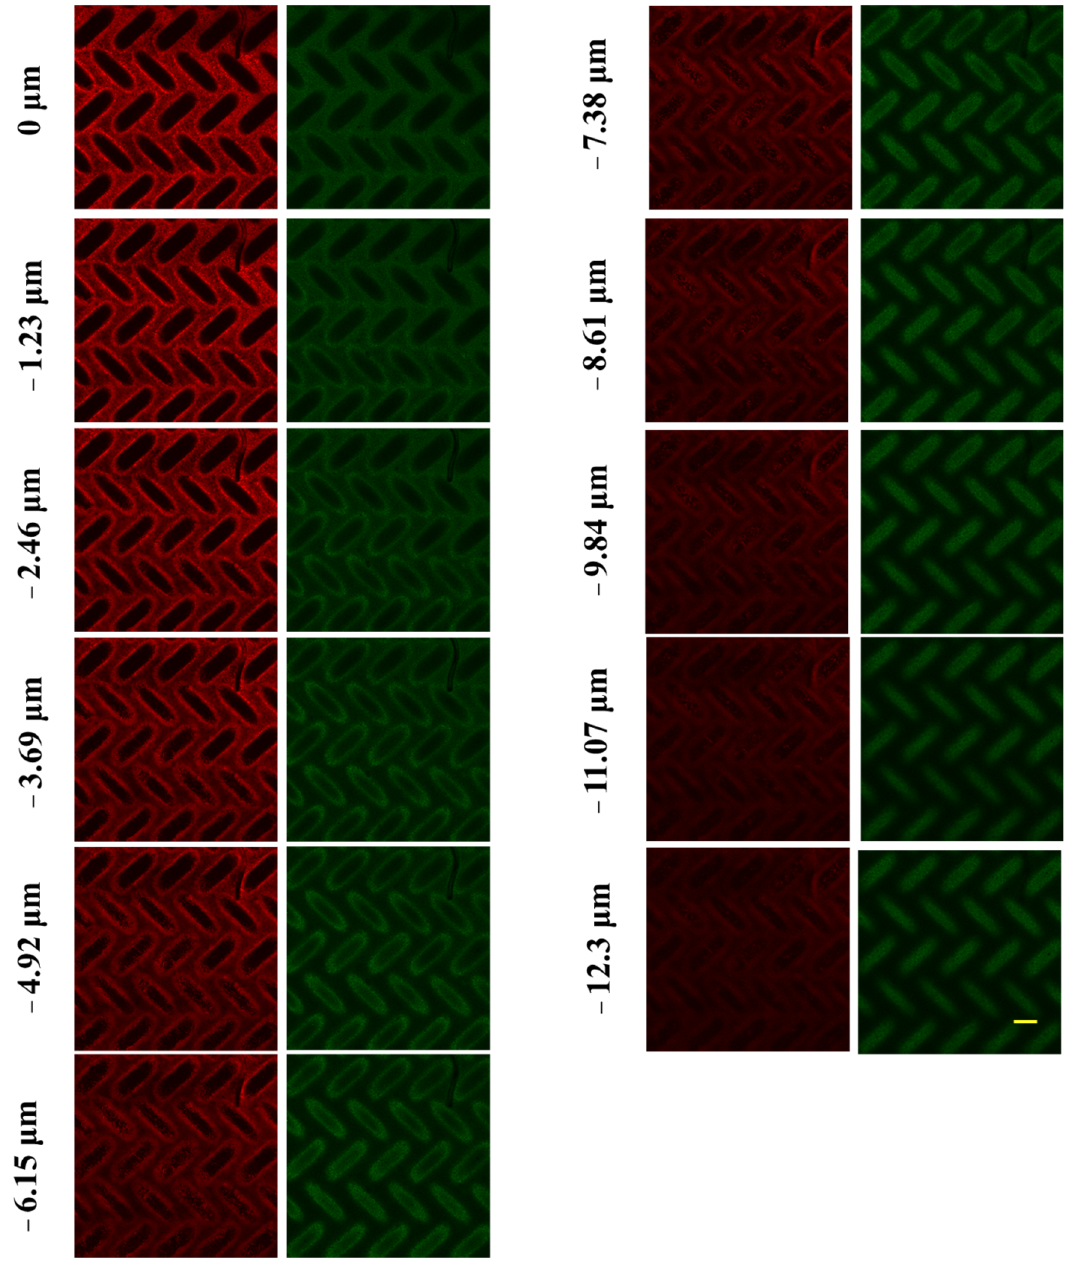
Figure 10. Confocal images after 2 min filtration of BSA solution. Images are shown for patterned membrane (green) and BSA foulant (red) at different depths from the surface (Z = 0). For better observation by the reader, light corrections (Brightness: +40% and Contrast: − 40%) were applied to the images. The common scale bar is 50 μ m.